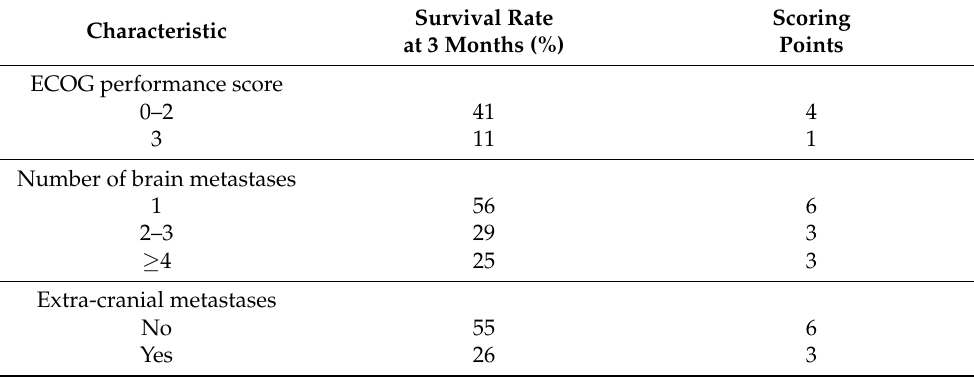
Table 3. Survival rates at 3 months and scoring points.